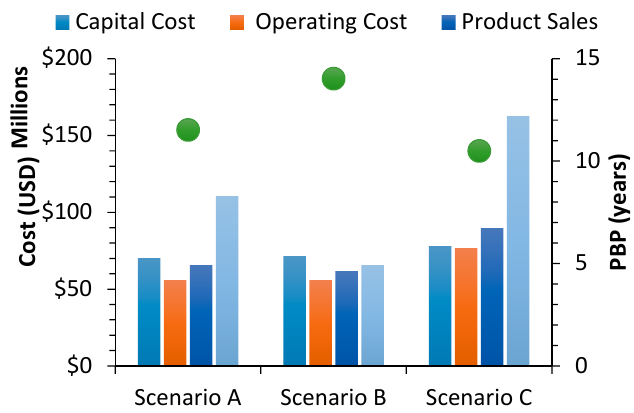
Figure 4. Economical evaluations for the different scenarios considered in this study.